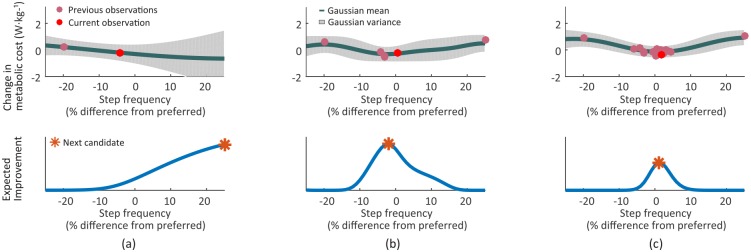
Bayesian optimization process.After collecting two data points, the posterior distribution was calculated (a, top) and expected improvement (EI) was estimated (a, bottom). By maximizing EI, the new candidate point was chosen and the cost was obtained. A new posterior is then computed (b) and the process was repeated until the termination criterion met (c). Above, we used hypothetical data and reduced the exploration points from three to two for a simple explanation.